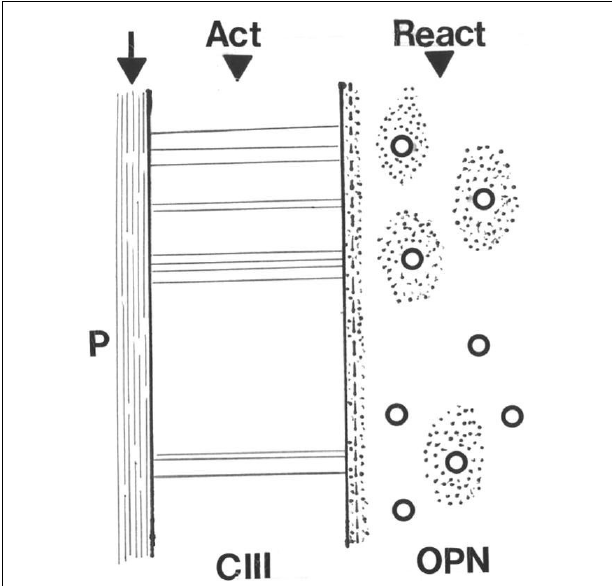
FIGURE 5 | Diagram illustrating the conductance of a hypothetical stimulus to the periosteal membrane (P) across the adjacent CIII-rich Sharpey fiber domain to its direct interface with the inner domain where the act is translated into a reaction of increased vascularity via osteopontin (OPN)-rich new haversian